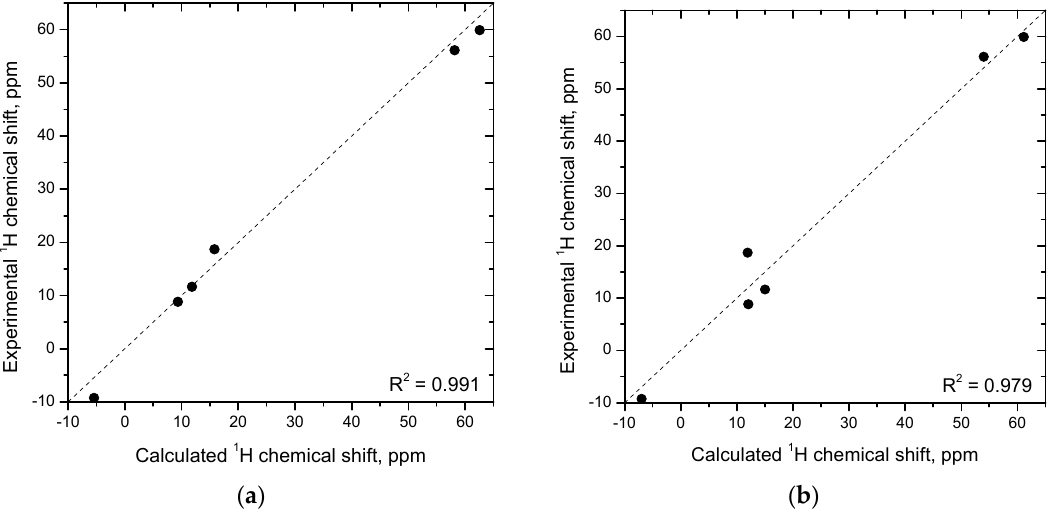
Figure 3. Correlation plot of experimental vs. theoretical 1 H chemical shifts for Fe( L1 ) 2 OTf 2 with PBE0- optimized ( a ) and X-ray geometries ( b ) of [Fe( L1 ) 2 ] 2+ ; (cid:1986)χ (cid:3028)(cid:3051) = 7.66·10 − 32 m 3 . For Fe( L2 ) 2 OTf 2 and Fe( L2 ) 2 (BF 4 ) 2 , see Figures S3 and